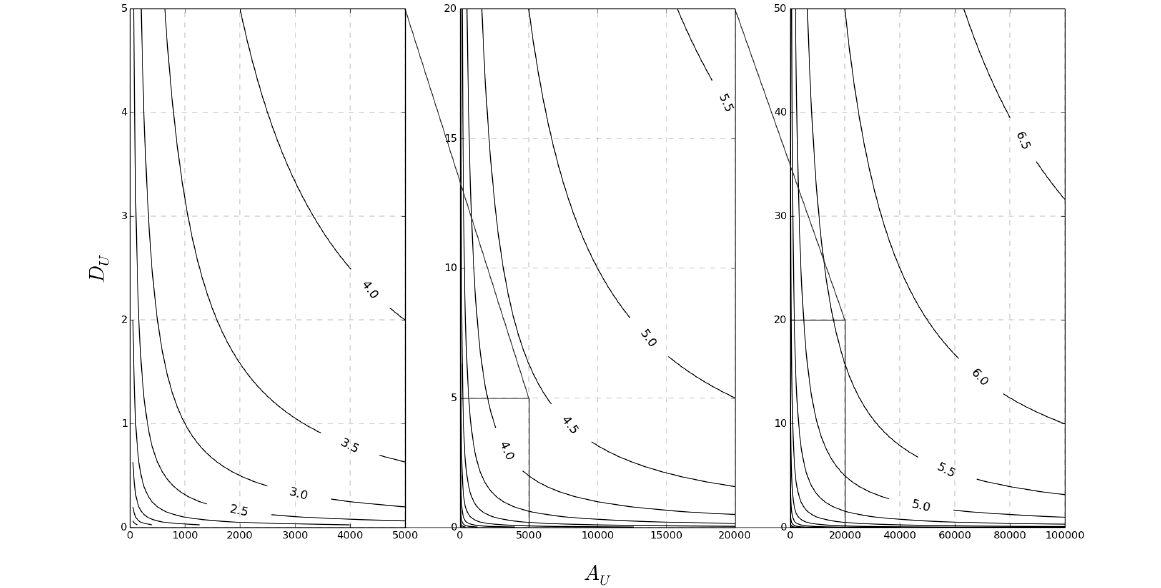
Simulated App Ecosystem